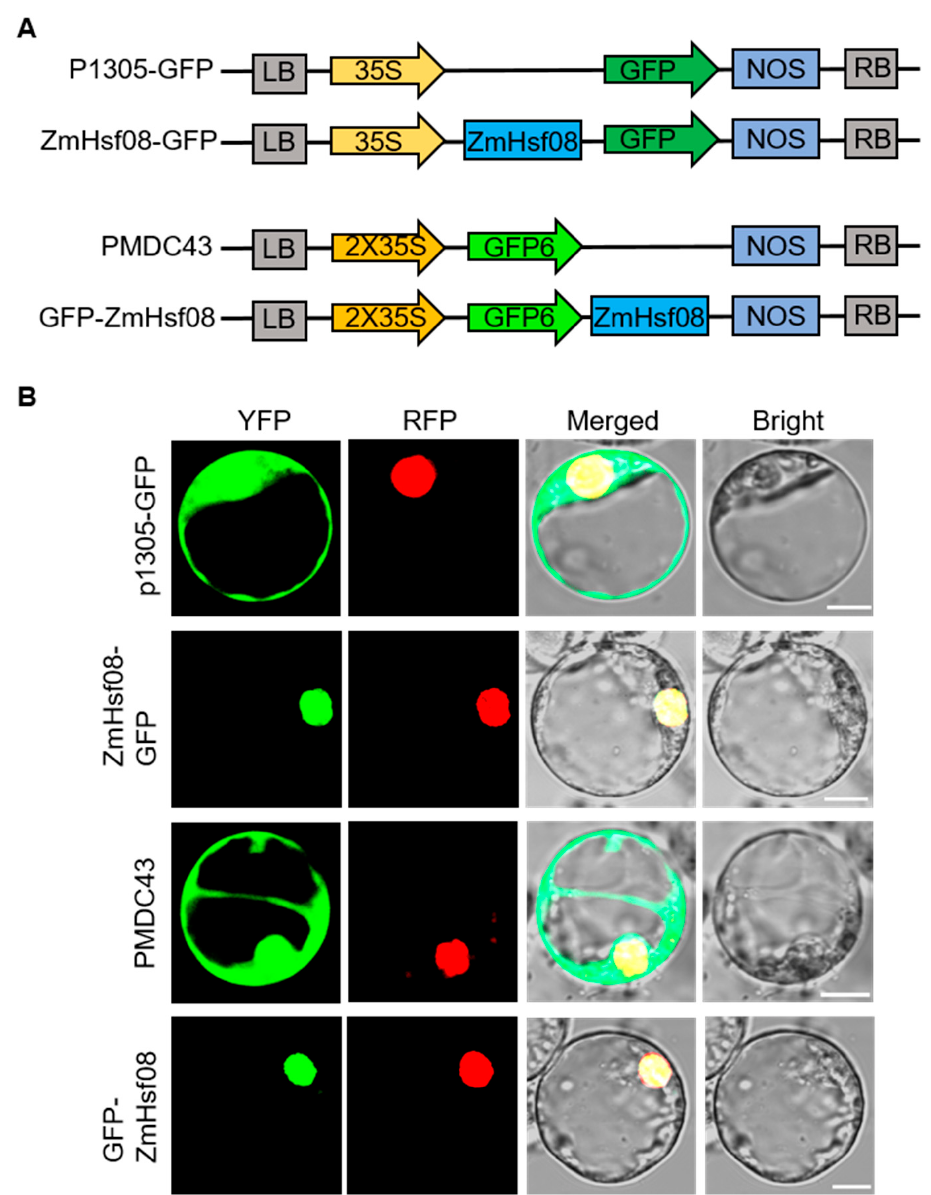
Figure 2. Subcellular localization of ZmHsf08 . ( A ) Vector diagram of p1305-GFP, PMDC43, GFP- ZmHsf08 and ZmHsf08 -GFP. ( B ) Fusion proteins were transiently expressed in maize protoplasts. Control, p1305-GFP vector and PMDC43 vector; ZmHsf08 -GFP and GFP- ZmHsf08 , ZmHsf08 fused with GFP. RFP is a marker for nucleus localization. Bars = 10 µm.